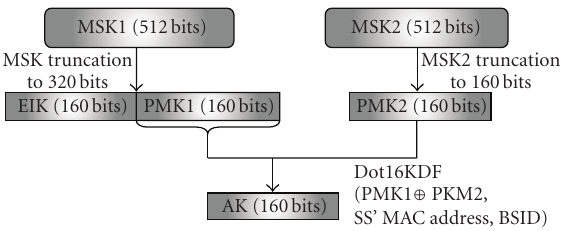
Figure 16: AK derivation with EAP-EAP